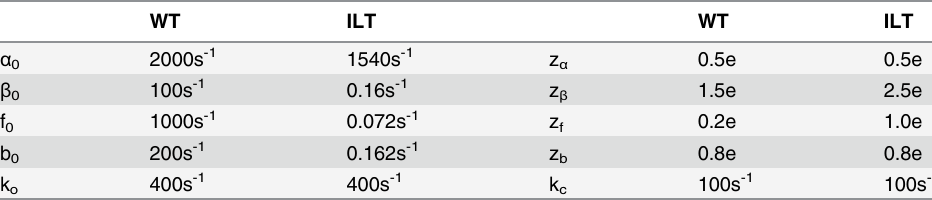
400s -1 100s -1 For WT, model based on Ref. [15] equilibrium model for g(V) and Q(V) curves with kinetic constants